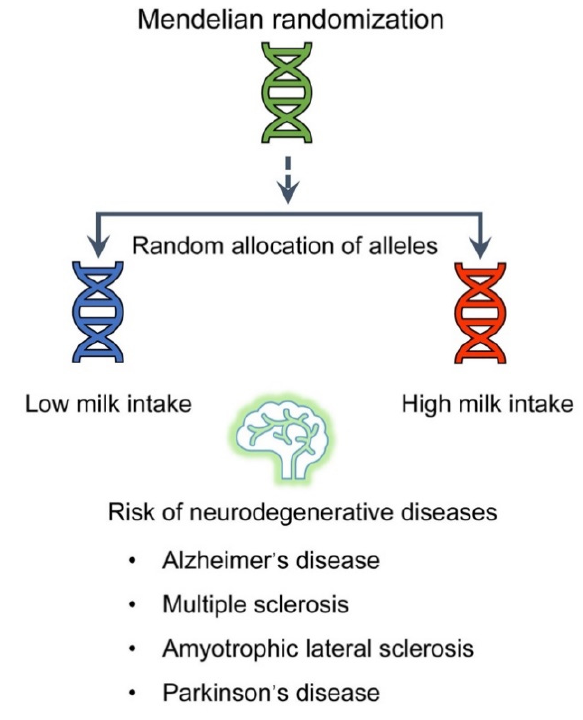
Figure 1. Overview of this MR study.